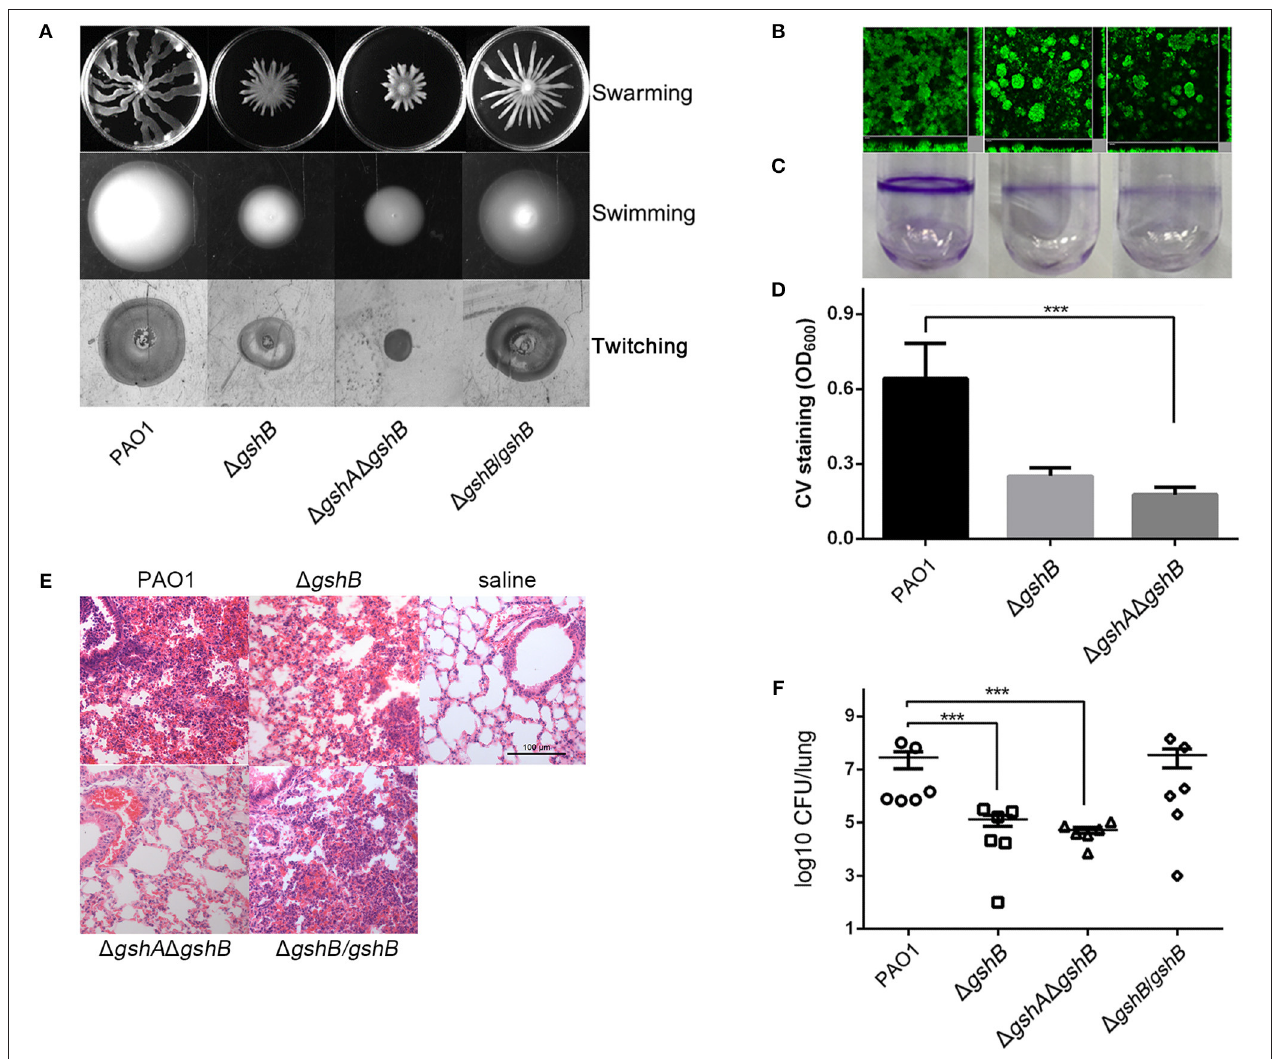
FIGURE 1 | GSH is important in P. aeruginosa pathogenicity. (A) 1 gshB and 1 gshA 1 gshB exhibited weaker swimming, swarming, and twitching motilities. The experiments were repeated at least three times with similar results. Images from one typical experiment are shown. (B) Biofilms of PAO1, 1 gshB and 1 gshA 1 gshB grown in flow cells for 72h and examined by confocal laser scanning microscopy. Experiments were performed in triplicate independently for three times. Representative images are shown. (C,D) Biofilm formation of PAO1, 1 gshB and 1 gshA 1 gshB on borosilicate tube surface and quantified by the crystal violet (CV) staining methods. The results are averages based on three replicate tubes. (E) H&E stained mouse lungs 16h post-infection by indicated P. aeruginosa strains. (F) 1 gshB and 1 gshA 1 gshB are attenuated in acute pneumonia infection. Bacterial burden in CD-1 mouse lungs ( n = 6) after 16h of infection by various P. aeruginos a strains. Data represent average CFU/lung ± standard deviations. *** p < 0.001, when compared PAO1 to 1 gshB and 1 gshA 1 gshB